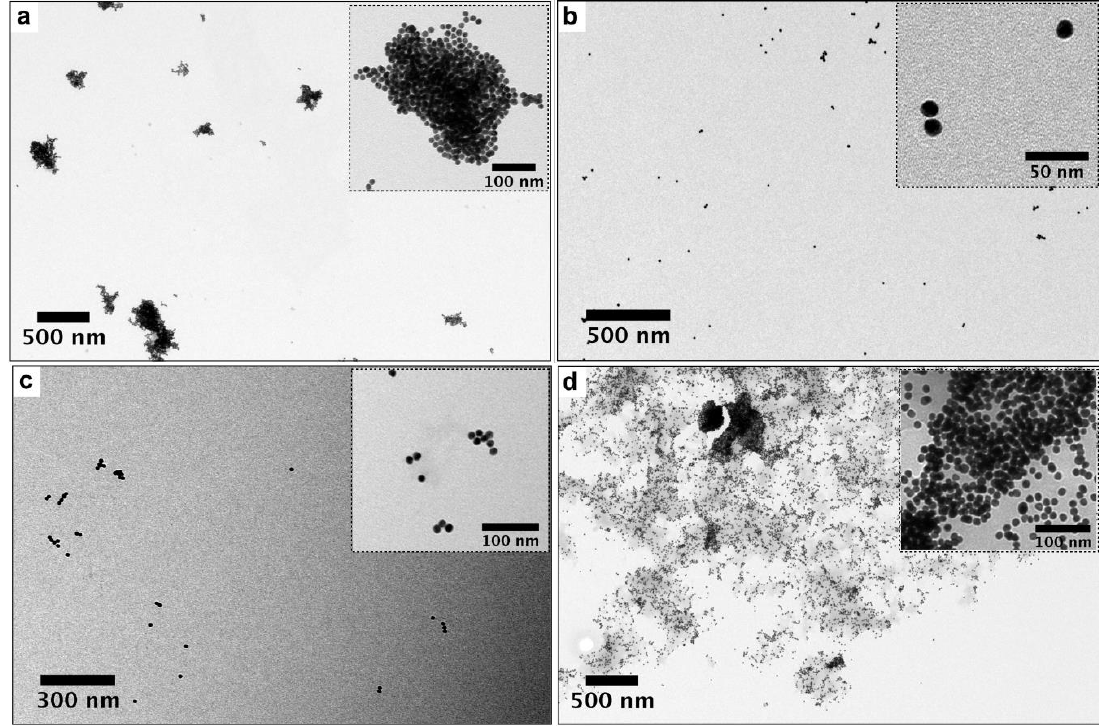
Figure 4. TEM images of AuNPs@EHL when different amounts of protein are added: ( a ) AuNPs@EHL- 2 (25 µL), ( b ) AuNPs@EHL- 3 (100 µL), ( c ) AuNPs@EHL- 5 (200 µL) , and ( d ) AuNPs@EHL- 2 (500 µL). In all cases, the nanoparticles go through two centrifugation cycles (14,000 rpm × 25 min) and are resuspended in MilliQ water.